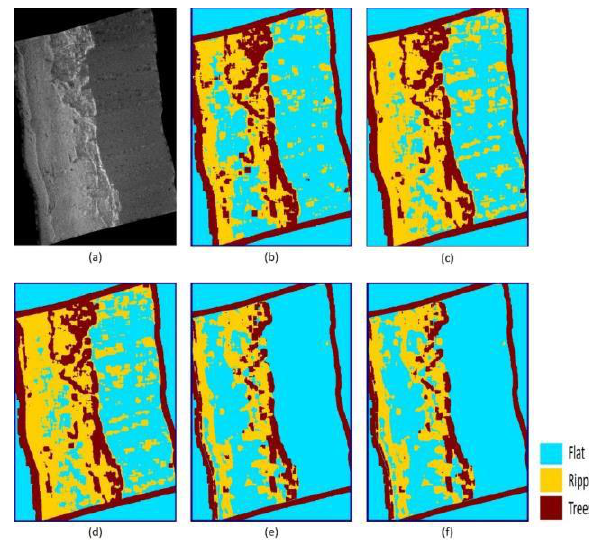
Figure 5. Results of variable combinations in SVM classification: (a) Input image, (b) Combination 1, (c) Combination 2, (d) Combination 3, (e) Combination 4, (f) Combination 5.